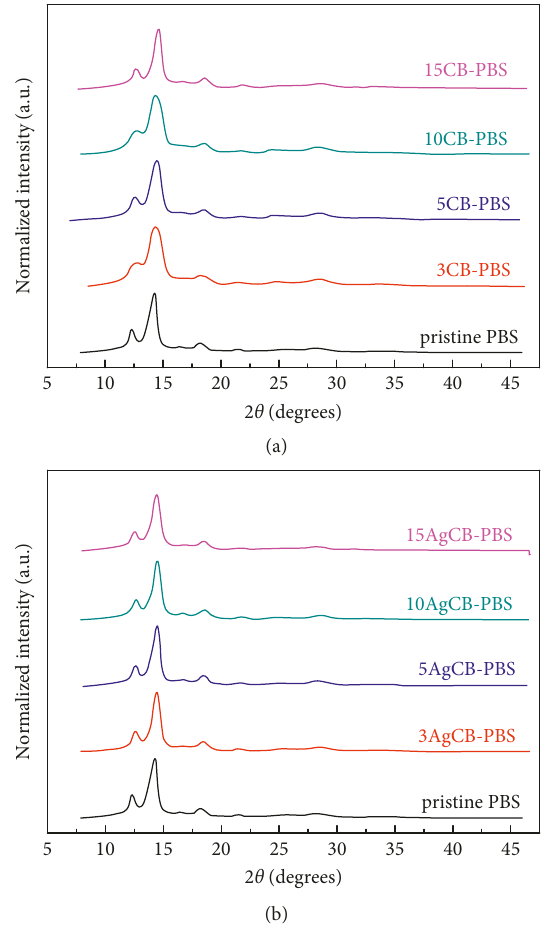
Figure 13: One-dimensional integration XRD patterns of the 1- year-aged (a) xCB-PBS composites and (b) xAgCB-PBS composites in comparison with the pristine PBS material obtained from the two-dimensional grazing incidence X-ray diffraction (2d-GIXRD) patterns using synchrotron monochromatic X-ray of energy 12keV (wavelength of 1.0332 ˚A) and grazing incidence angle of 0.5 °